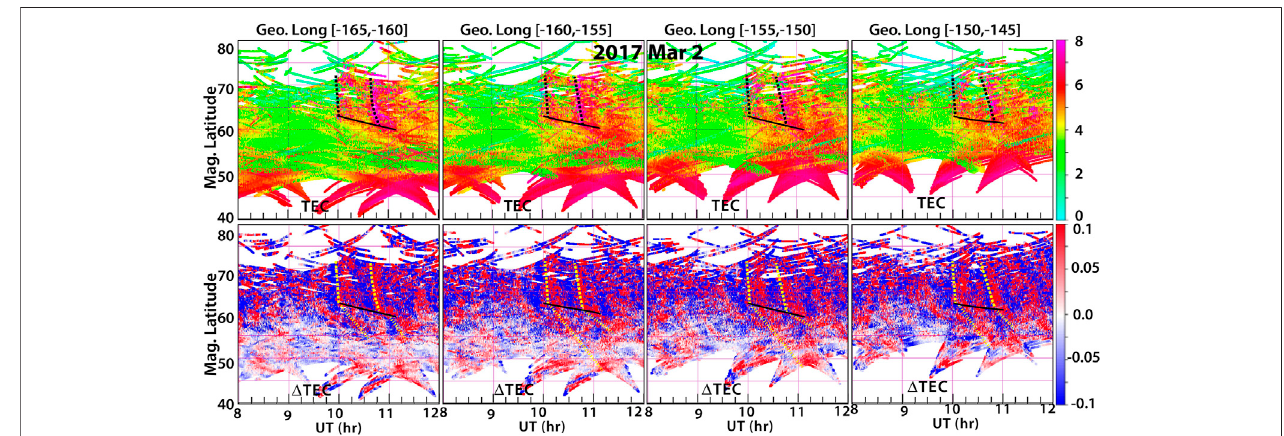
FIGURE 4 | All TEC and Δ TEC data points within 5 ° geographic longitude bins from west of, to near, Poker Flat ( − 147.4 ° longitude) on March 2, 2017. The black solid curves give an approximation of the equatorward boundary of the electron auroral oval based on the auroral emissions in Figures 2 , 3 . The initial time edges of streamer Δ TEC enhancement regions are marked with yellow longer dashed lines (black dashed in the TEC panels). Initial edges of the more equatorward regions of equatorward moving Δ TEC enhancement are marked by yellow shorter dashed lines.